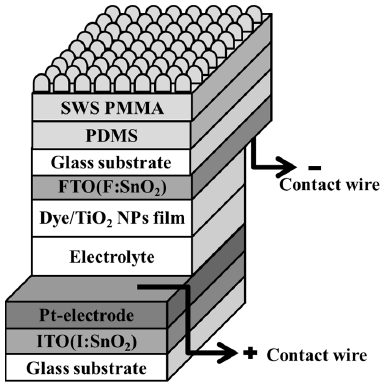
Figure 1. Structure diagram of a subwavelength structured (SWS) anti-reflective film combined with a dye-sensitized solar cell.